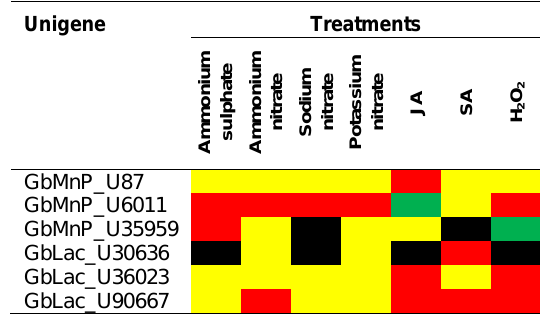
Figure 6. Summary of transcription regulation of genes encoding GbMnP and GbLac. Red, up-regulation ≥ 2-fold; green, down-regulation ≥ 2-fold; yellow not di ff erentially expressed and black, suppressed.